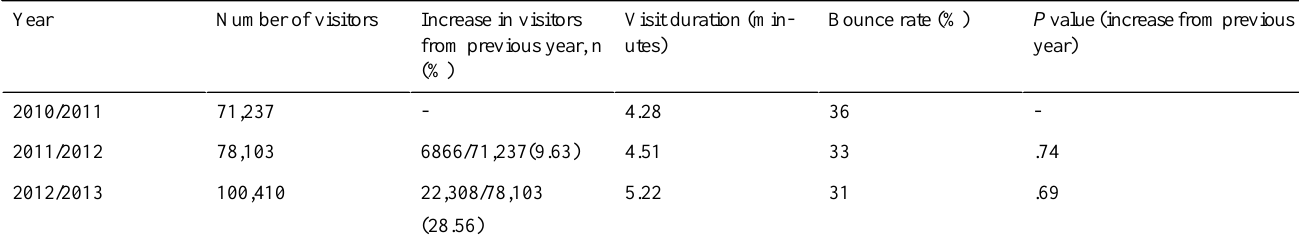
Table 1. The number, duration, and bounce rate of visitors to the e-Bug website over the last three academic years.